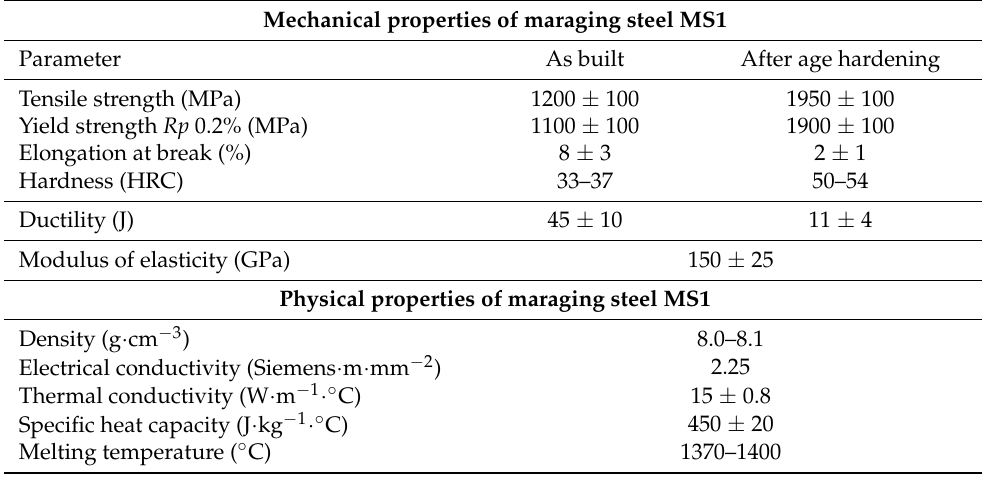
Table 3. Mechanical and physical properties of steel MS1 [52].